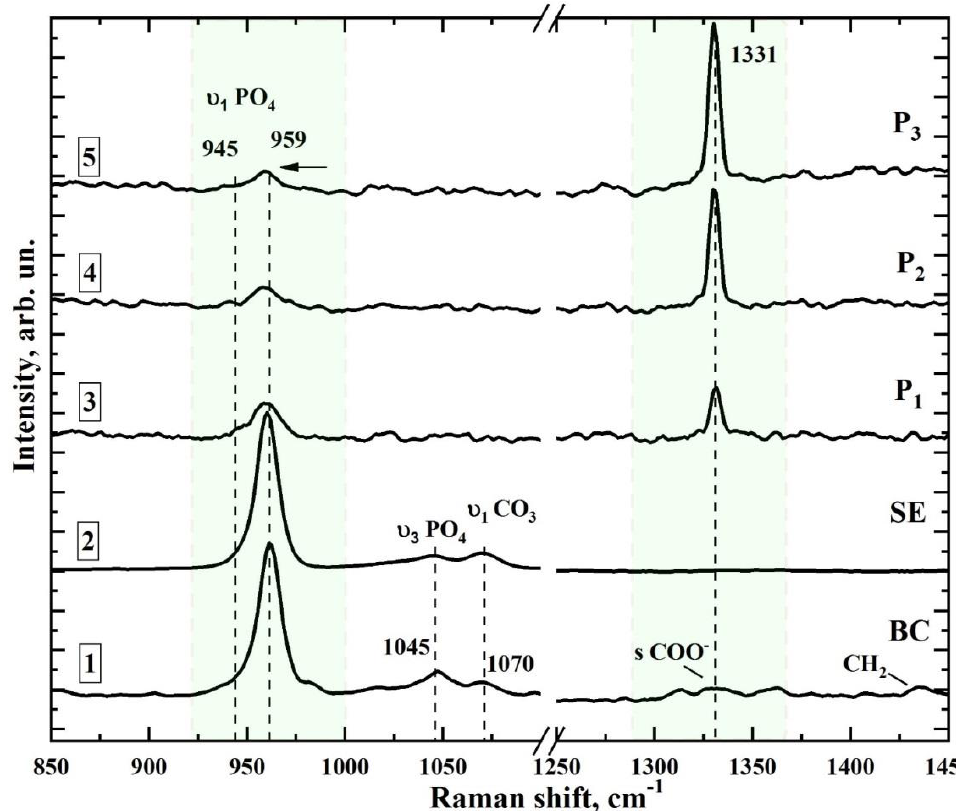
Figure 6. Results of microRaman spectroscopy of the different microregions of sample E (demineralisation of the lateral wall of the fissure, incipient caries in the fissure, ICDAS 1) after fluorescence background correction .